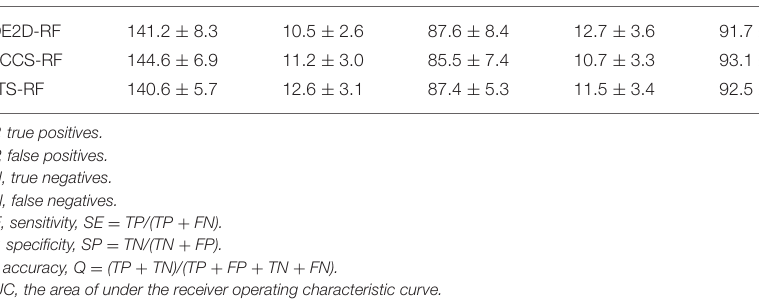
TABLE 1 | Performance of the RF classification models by using different molecular descriptors. Models